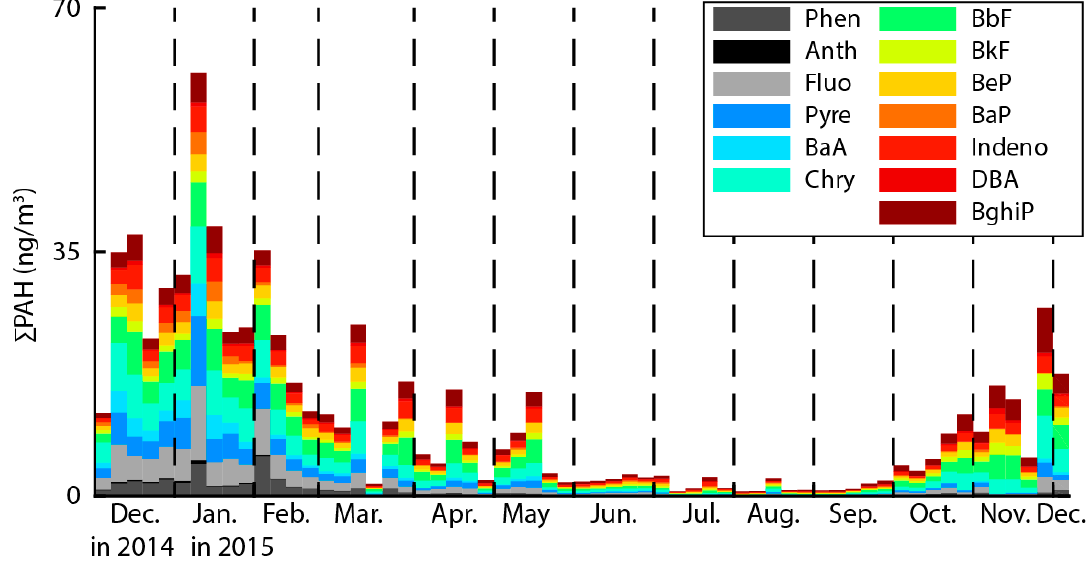
Figure 2. Time series concentrations of PAHs in PM 2.5 at the sampling site.